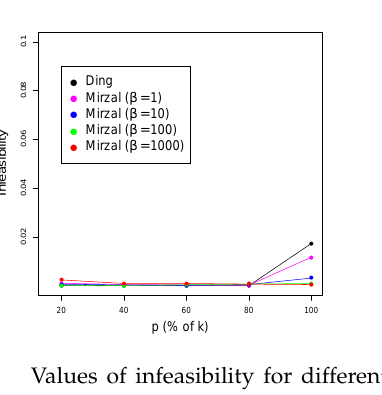
Values of infeasibility for different values of β obtained by Algorithms 1 and 3 on BION data with n = 500.